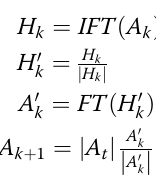
algorithm. Gerchberg-Saxton (GS) algorithm is a widely used iterative algorithm to optimize the phase distribu-